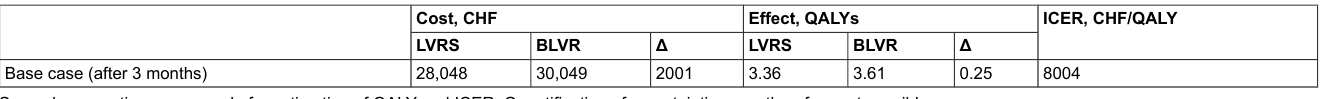
Table 7: Incremental cost-effectiveness results after three